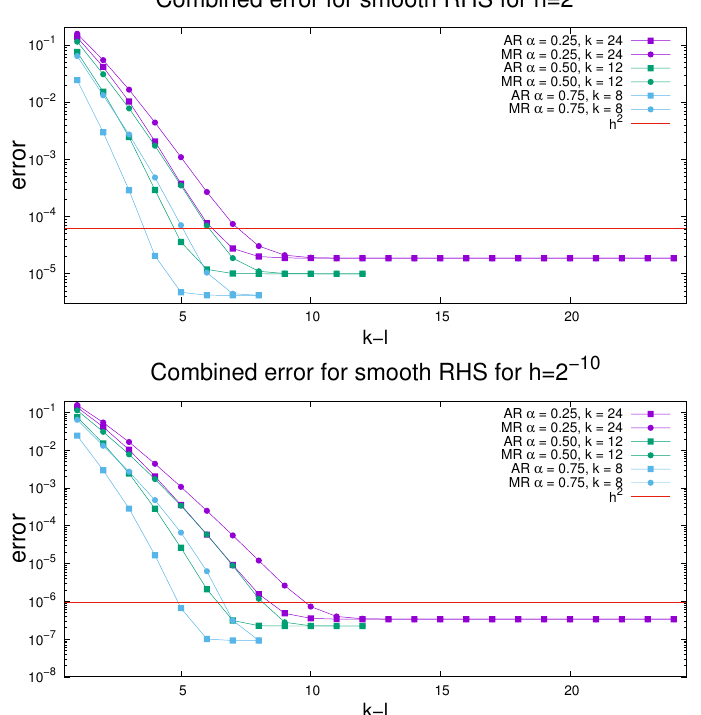
Figure 5. The overall error (11) for 3D homogeneous fractional Laplacian with smooth right-hand side f on [ 0,1 ] 3 . Uniform mesh with h = 1/128 ( top ) and h = 1/1024 ( bottom ) is